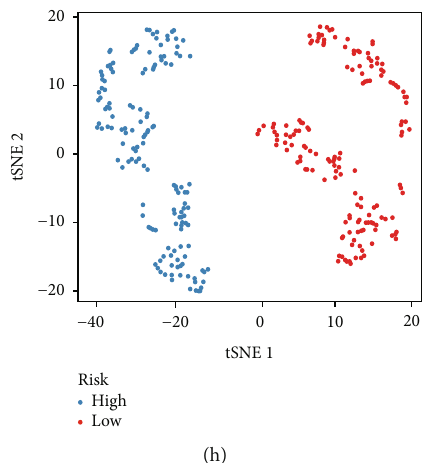
Figure 5: Risk curve and t-SNE dimension reduction analysis. (a, c, e) In TCGA dataset, we explored the distribution of model genes in the high- and low-risk groups and the survival of gastric cancer patients with increasing risk values. Similarly, (b, d, f) are the above results in the GSE62254 dataset. (g, h) The t-SNE dimension reduction analysis in TCGA and GSE62254 datasets, respectively. p value Hazard ratio